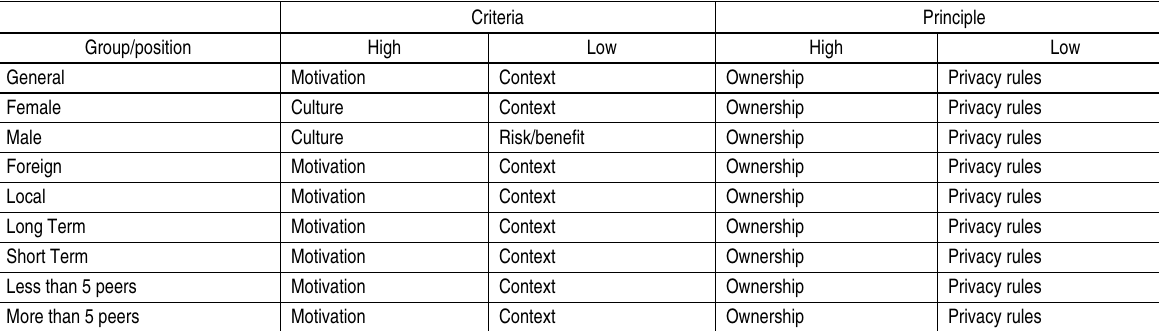
Table 3. Ratings of principles and criteria of Communication Privacy Management of